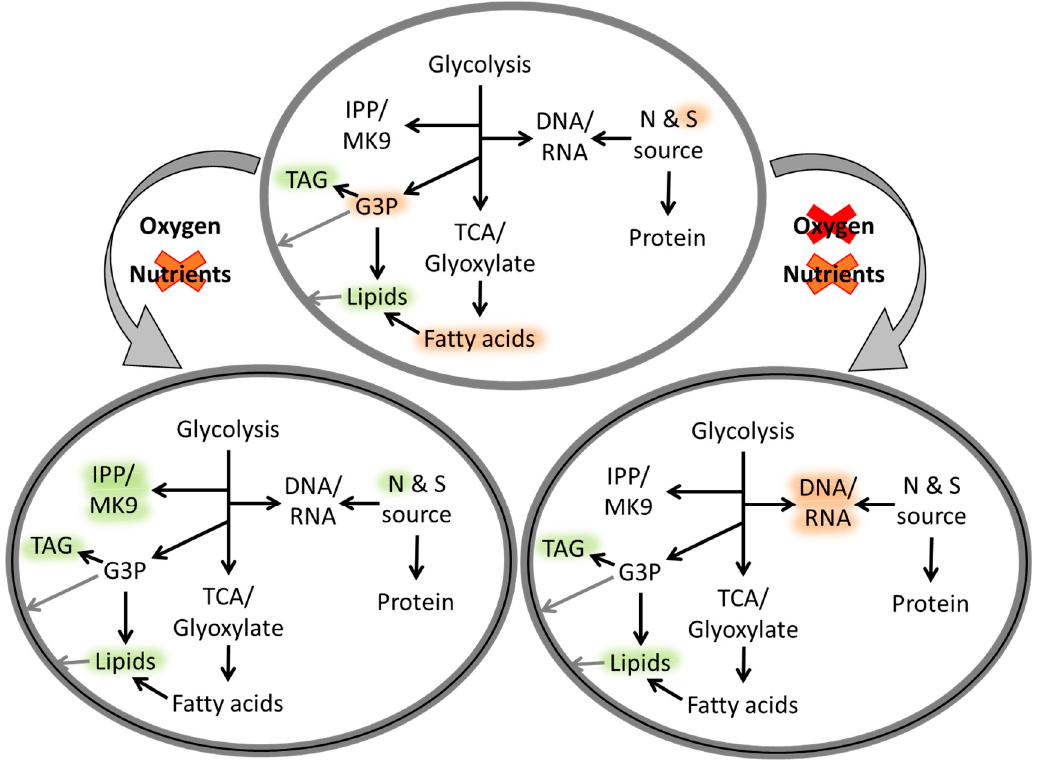
Figure 4. Schematic representation of metabolic processes of mycobacterial cells under changes/depletion of oxygen and nutrients levels (grey curved arrows), adapted from Drapal, M.; et al. Microbiology 2016 , 162 , 1456–1467. Copyright © 2016 Microbiology Society [45]. Intracellular metabolic processes are indicated with black arrows and regulation highlighted as up ( green ) or down ( red ).